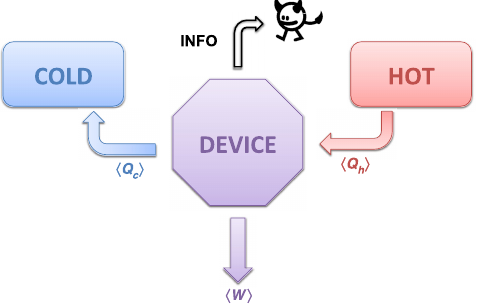
FIG. 1. Thermodynamic setup: A device exchanges heat with thermal reservoirs and work with a work source. The process is observed by a Maxwell